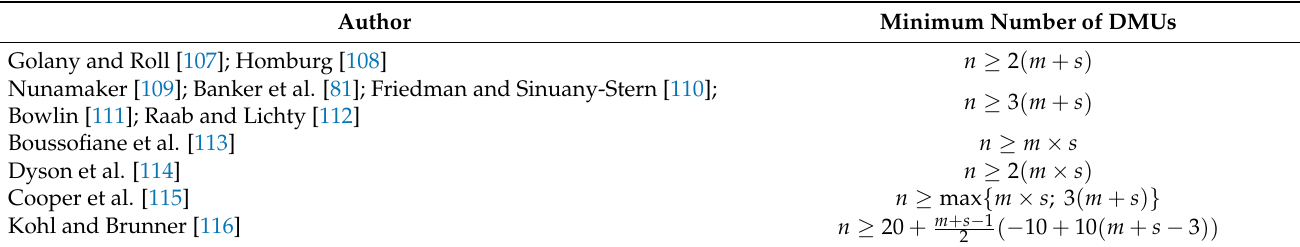
Table 1. Empirical rules of the minimum number of